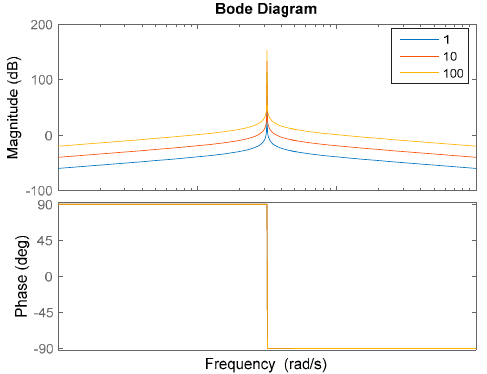
Figure 7. Bode diagram with different η values of ADALINE based on the LMS algorithm.